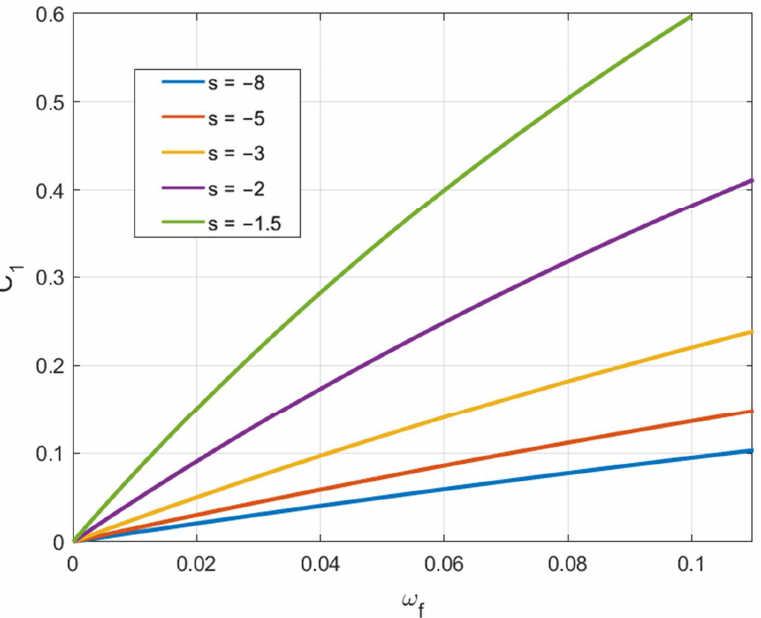
C Figure 9. Variation of C 1 involved in Equation (54) with the axial feeding for several loading paths. Figure 9. Variation of 1 involved in Equation (54) with the axial feeding for several loading paths. Substituting Equations (7), (32) and (51) into Equation (50) gives Substituting Equations (7), (32) and (51) into Equation (50) gives